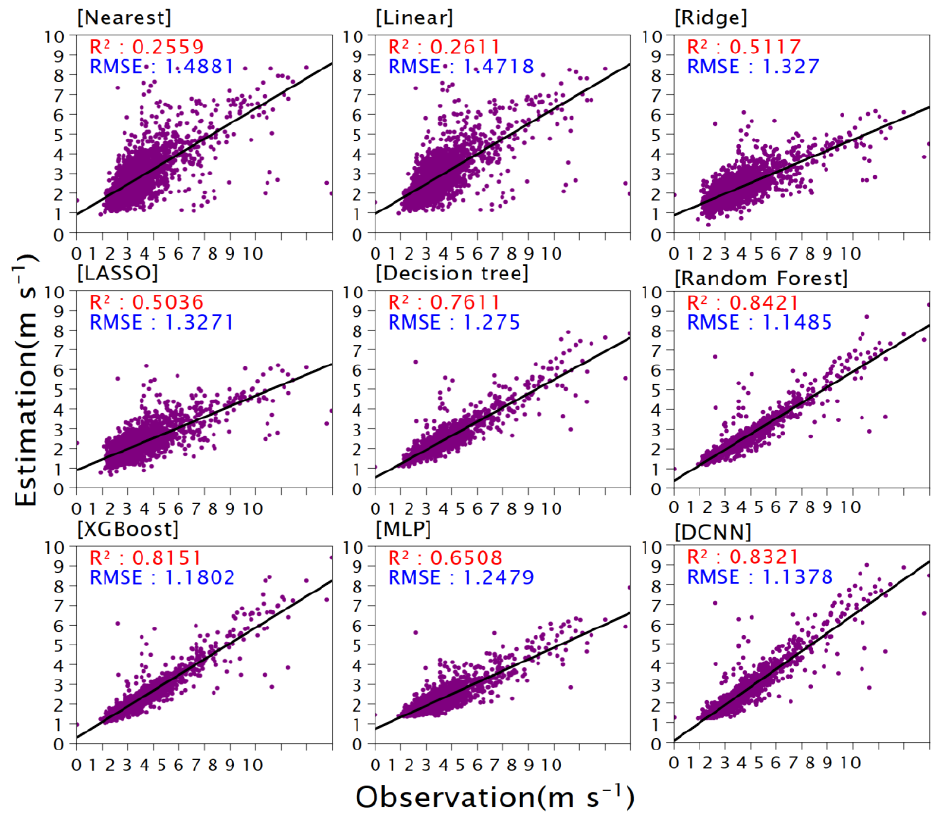
Figure 9. Correlation analysis of observed winter wind speeds and those predicted by each method.